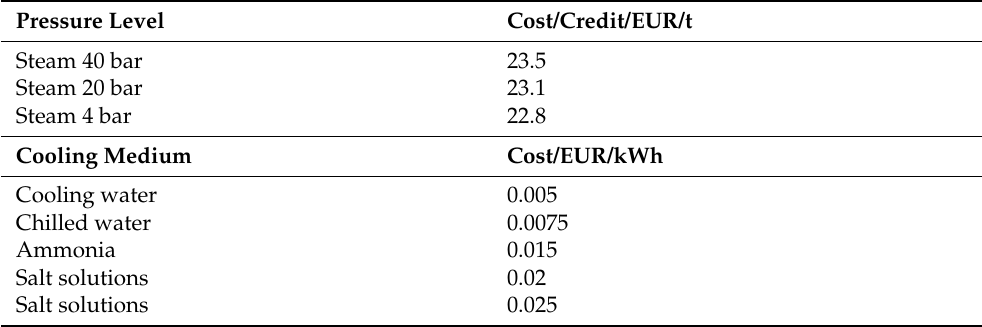
Table 3. Steam and cooling cost depending on steam pressure level and employed cooling